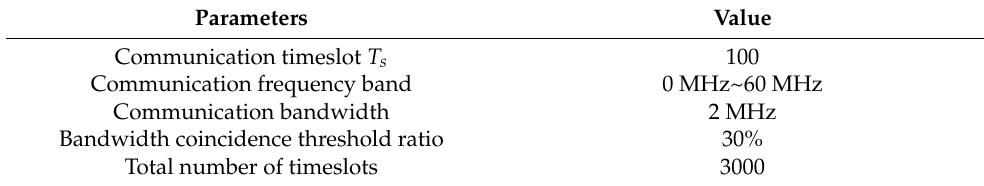
Table 4. Simulation parameters of the decision-making algorithm.